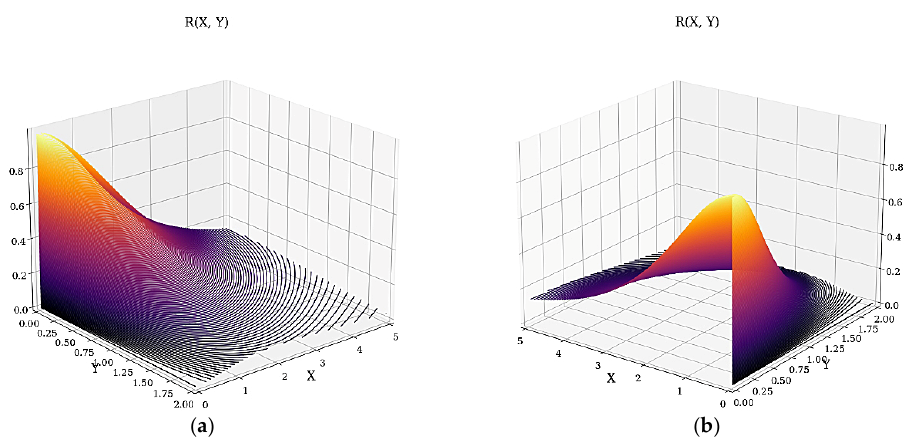
Figure 3. ( a , b ) The 2D dependencies of T = T (X, Y): ( a ) T = T (X, Y = constant); ( b ) T = T (X = constant, Y). In Figure 4a,b, the 3D dependencies of R on X and Y are given.